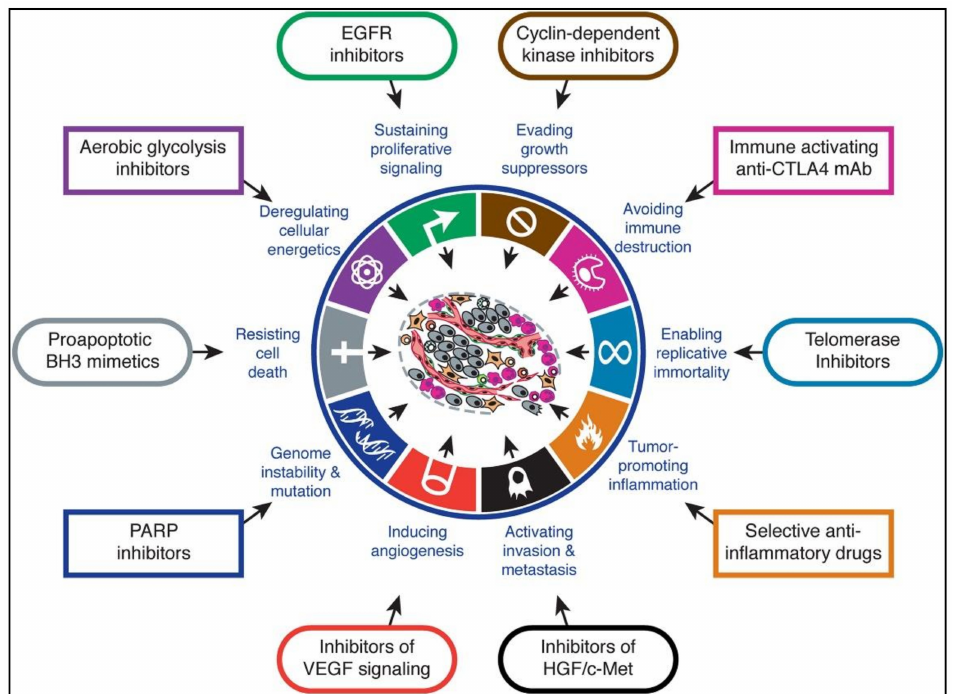
Figure 6. Therapeutic targeting of the hallmarks of cancer drugs that interfere with each of the acquired capabilities necessary for tumor growth and progression have been developed and are in clinical trials or in some cases approved for clinical use in treating certain forms of human cancer. Additionally, the investigational drugs are being developed to target each of the enabling characteristics and emerging hallmarks depicted in Figure 3, which also hold promise as cancer therapeutics. The drugs listed are but illustrative examples; there is a deep pipeline of candidate drugs with di ff erent molecular targets and modes of action in development for most of these hallmarks. Reproduced with permission from Hanahan & Weinberg. Hallmarks of Cancer: The Next Generation, Cell 144, 4 March 2011 Elsevier Inc. 2011,144(5), 646–674